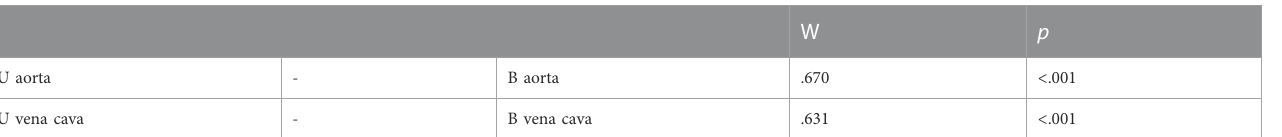
TABLE 2 Test of normality (Shapiro-Wilk).